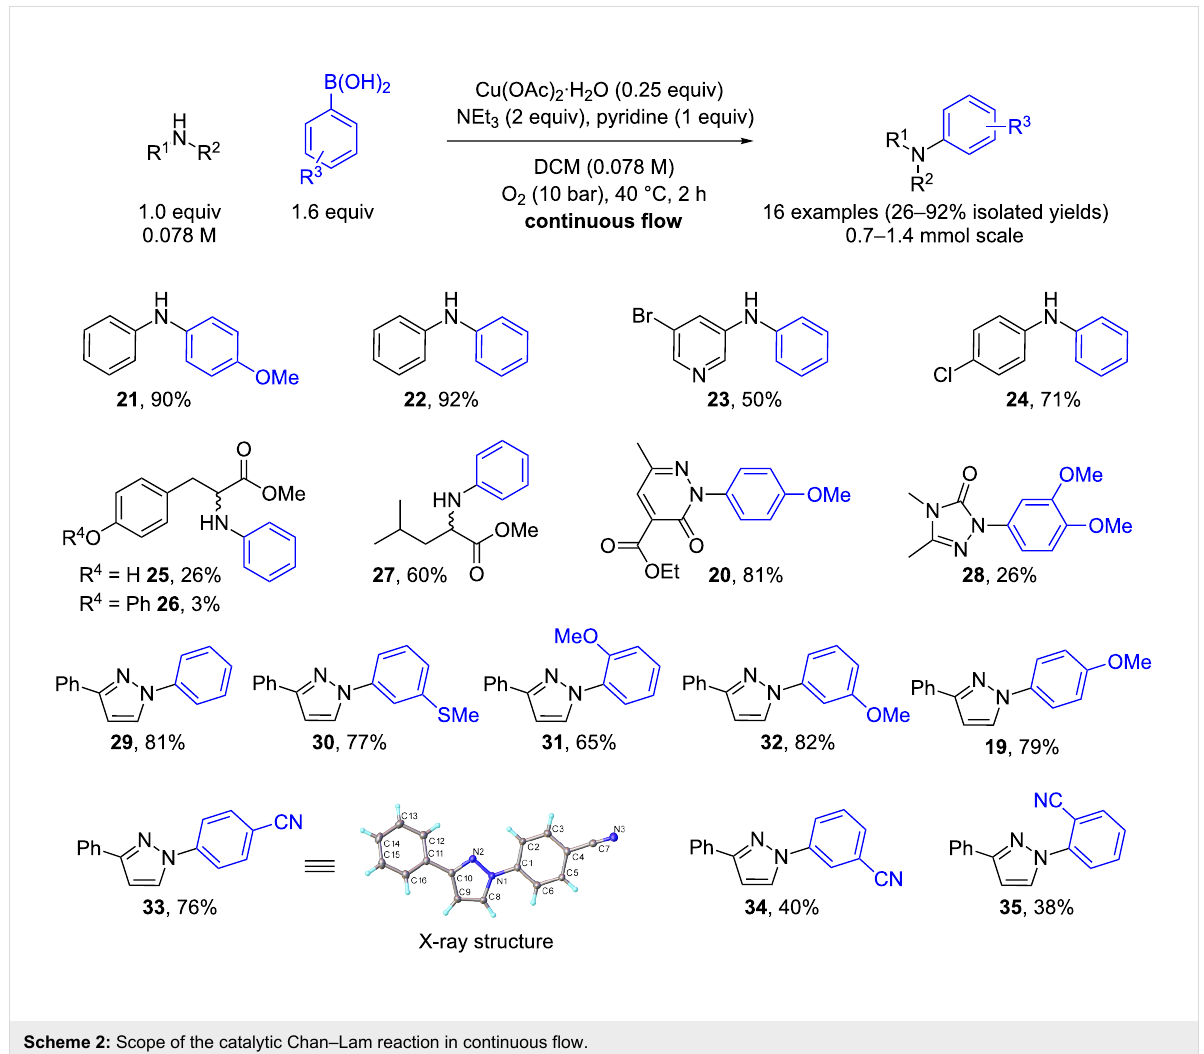
Scheme 2: Scope of the catalytic Chan–Lam reaction in continuous